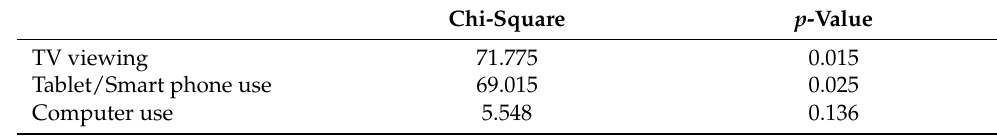
Table 6. Association between duration of technological devices use and nutrition score of children. Chi-Square p -Value TV viewing 71.775 0.015 Tablet/Smart phone use 69.015 0.025 Computer use 5.548